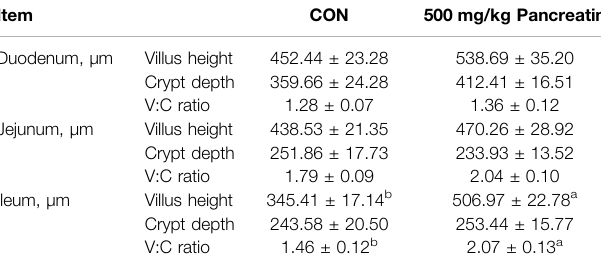
TABLE 6 | Effect of pancreatin on the small intestine morphology of piglets.